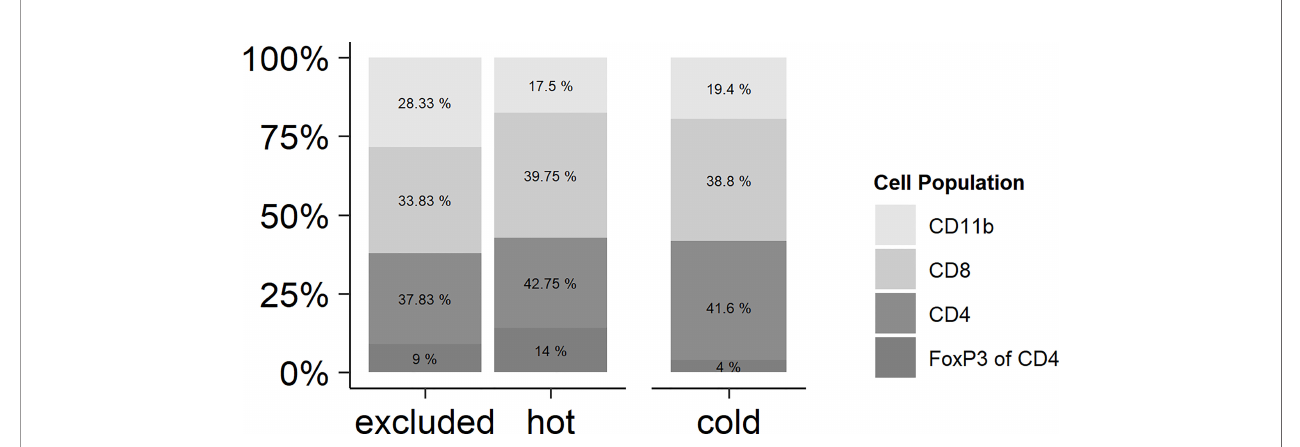
FIGURE 1 | Relationships of the immune cell types in hot, cold, and excluded tumors. While the total number of immune cells differed between hot and excluded tumors on the one hand and especially cold tumors on the other hand, the relationships of CD11b-positive myeloid cells, CD8-positive T lymphocytes, and CD4 T positive lymphocytes were very similar in all three tumor immune types. There was a trend of a higher proportion of CD11b-positive myeloid cells in excluded tumors, but this difference was not statistically signi fi cant ( p > 0.05). In CD4-positive T lymphocytes, the percentage of FoxP3-positive regulatory T cells (Tregs) was related to all CD4-positive cells. There was no signi fi cant difference in the proportion of Tregs between hot, cold, and excluded